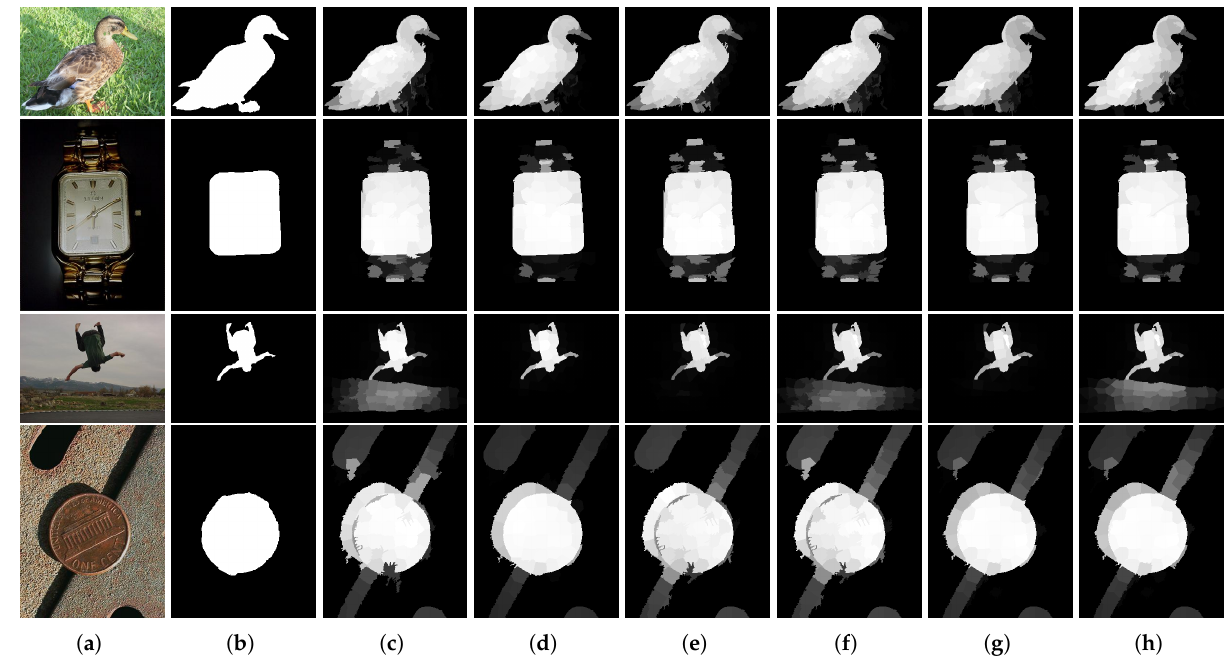
Figure 8. Visual comparison for RBD [49]. ( a ) Input images; ( b ) ground truth; ( c ) results of RBD; ( d ) BF; ( e ) ODOG; ( f ) LODOG; ( g ) BF+ODOG; ( h ) BF+LODOG.